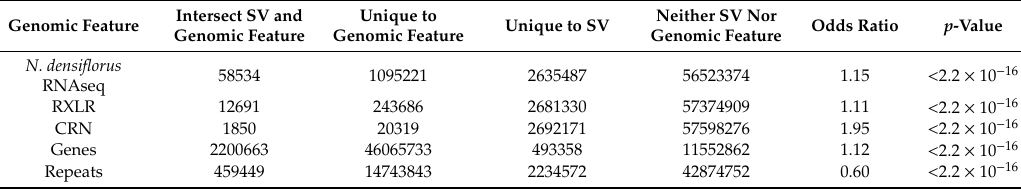
Table 3. Fisher’s exact test between parallel SVs with highest persistence times and genes up-regulated in P. ramorum NA1 when infecting N. densiflorus , pathogenicity genes (putative RXLRs and CRNs), genic regions, and repetitive regions. A contingency table was constructed showing the number of base pairs found in both the SV region and genomic feature (second column), unique to the genomic feature (third column), unique to the SV region (fourth column), and found in neither significant SV region nor genomic feature (fifth column). The odds ratio and p -value of the Fisher’s exact test is also shown in the sixth and seventh column,